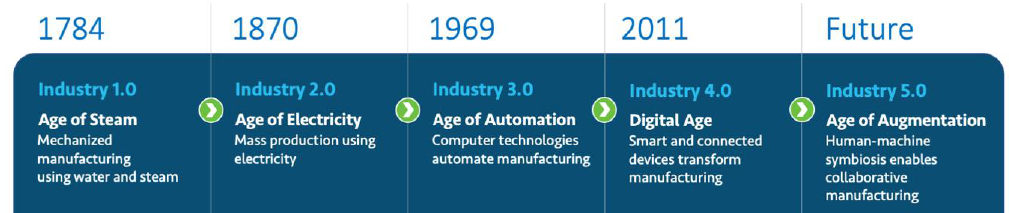
Figure 1. Moving to the fifth industrial revolution or Industry 5.0: the Age of Augmentation. 110